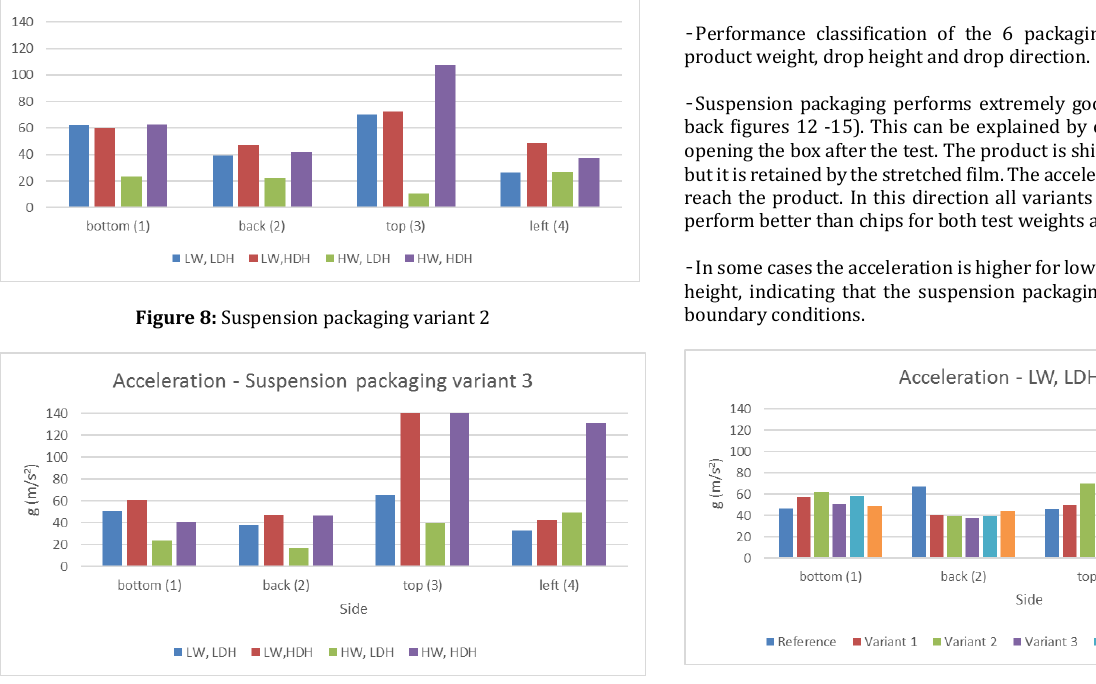
Figure 9: Suspension packaging variant 3